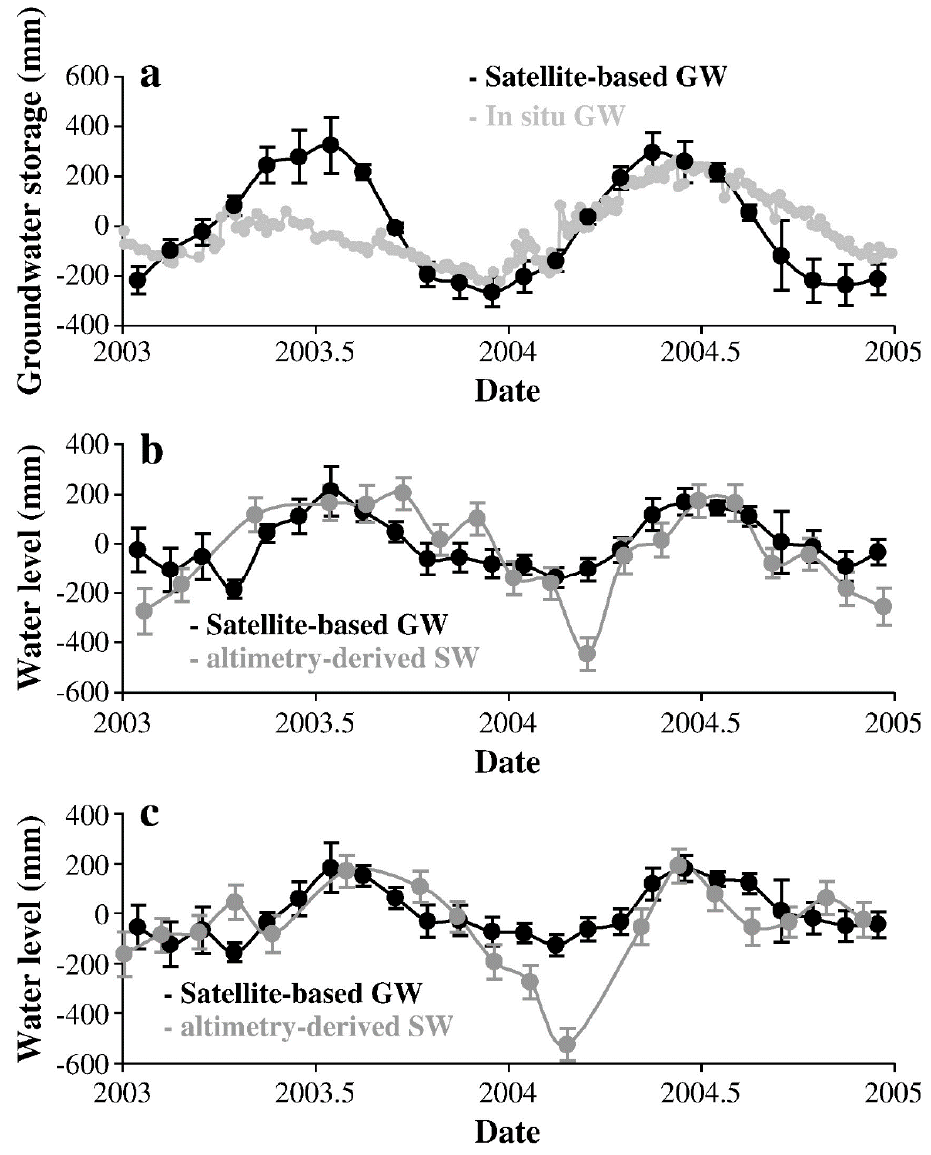
Figure 4. Time variations of the groundwater (GW) storage from GRACE and external information (black) in different locations of the Negro-River basin (Amazon): ( a ) in the Asu catchment (in situ GW storage in gray), ( b , c ) in the swamps of Caapiranga and Morro da Água Preta, respectively (altimetry-derived SW storage in gray), from [70].